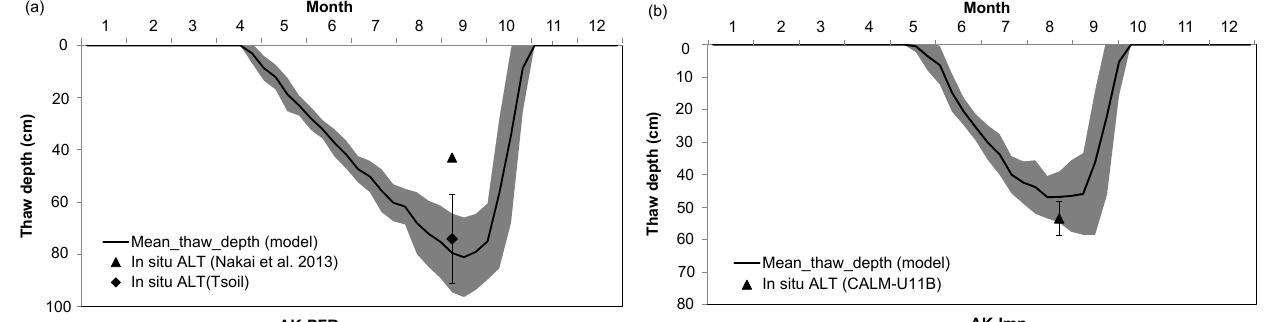
Figure 2. Model-simulated mean (2001–2015) soil thawing depth at the boreal forest ( a , AK-PFR) and tundra ( b , AK-Imn) sites, relative to in situ ALT values. At the AK-PFR site, the in situ ALT value reported by Nakai et al. (2013) was different from the ALT value calculated from in situ soil temperature ( T soil ) measurements, while at the tundra site the in situ ALT was calculated from observations at the Imnavait Creek 1km grid CALM site encompassing the AK-Imn tower site. Vertical error bars and dark gray shading indicate 1-standard-deviation variability in soil thaw depth or ALT during the study period.